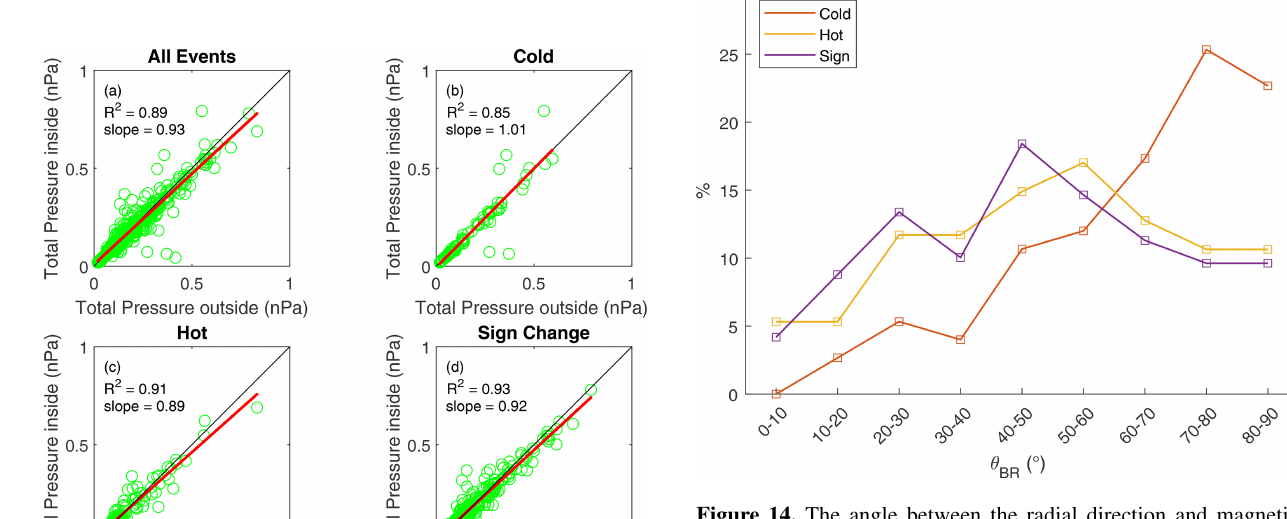
Figure 11. Sign change hole of Fig. 10 transformed into an MVA coordinate system.